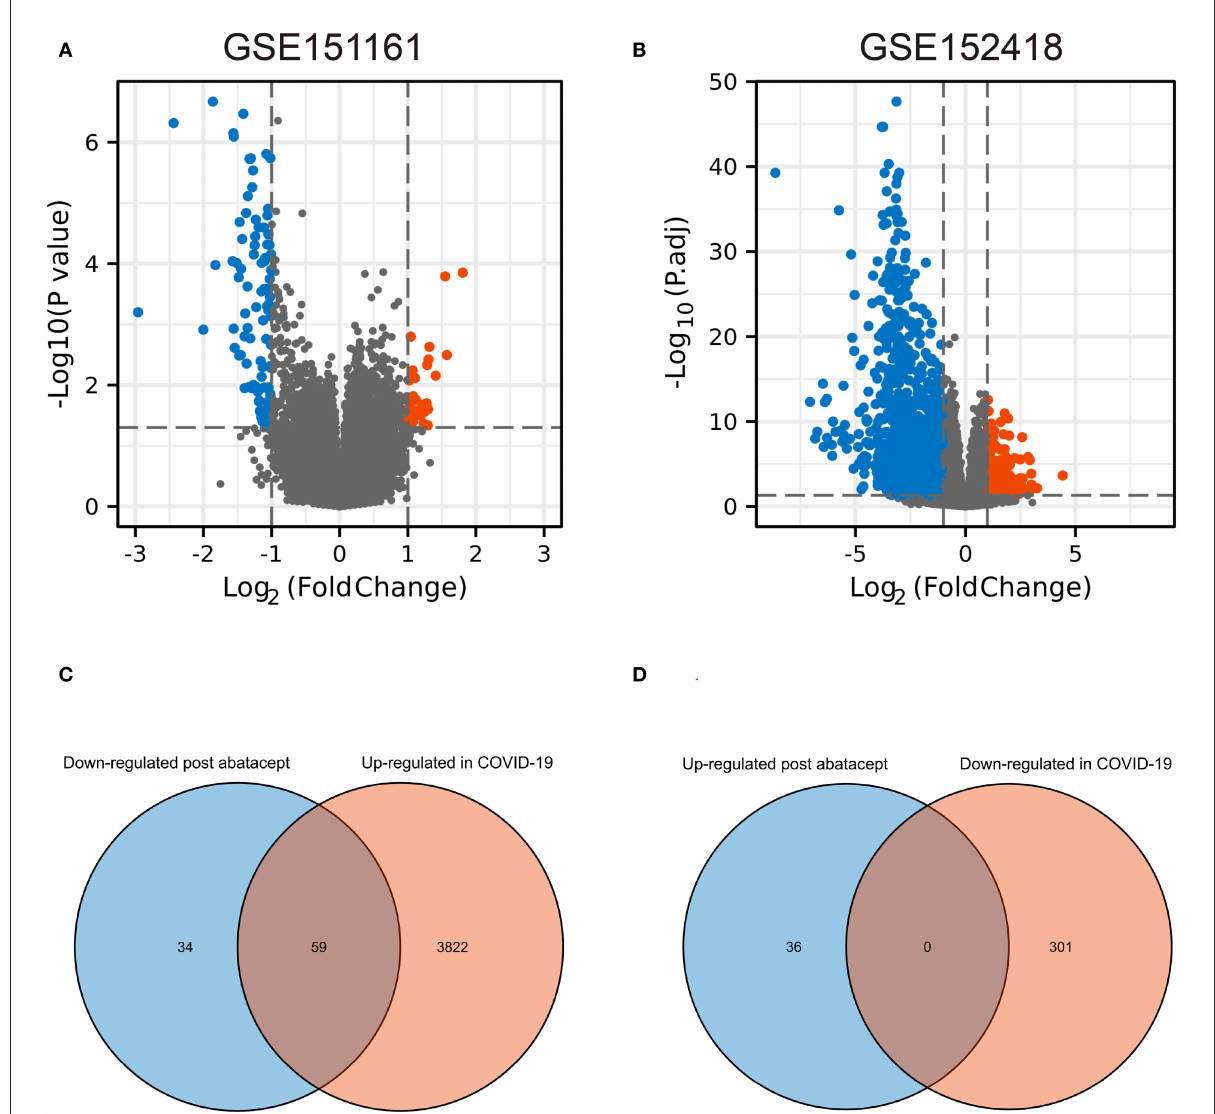
FIGURE1 The volcano map and Venn diagram between two datasets. (A) Differential expression genes (DEGs) of GSE151161. Ninety-three genes were downregulated and 36 genes were upregulated post abatacept treatment (12 weeks) in rheumatoid arthritis patients. (B) Differential expression genes of GSE151161. Three hundred and one genes were down-regulated and 3,881 genes were upregulated in COVID-19 patients. (C) Fifty-nine DEGs were upregulated in COVID-19 patients and downregulated post abatacept treatment. (D) Zero DEG was downregulated in COVID-19 patients and upregulated post abatacept